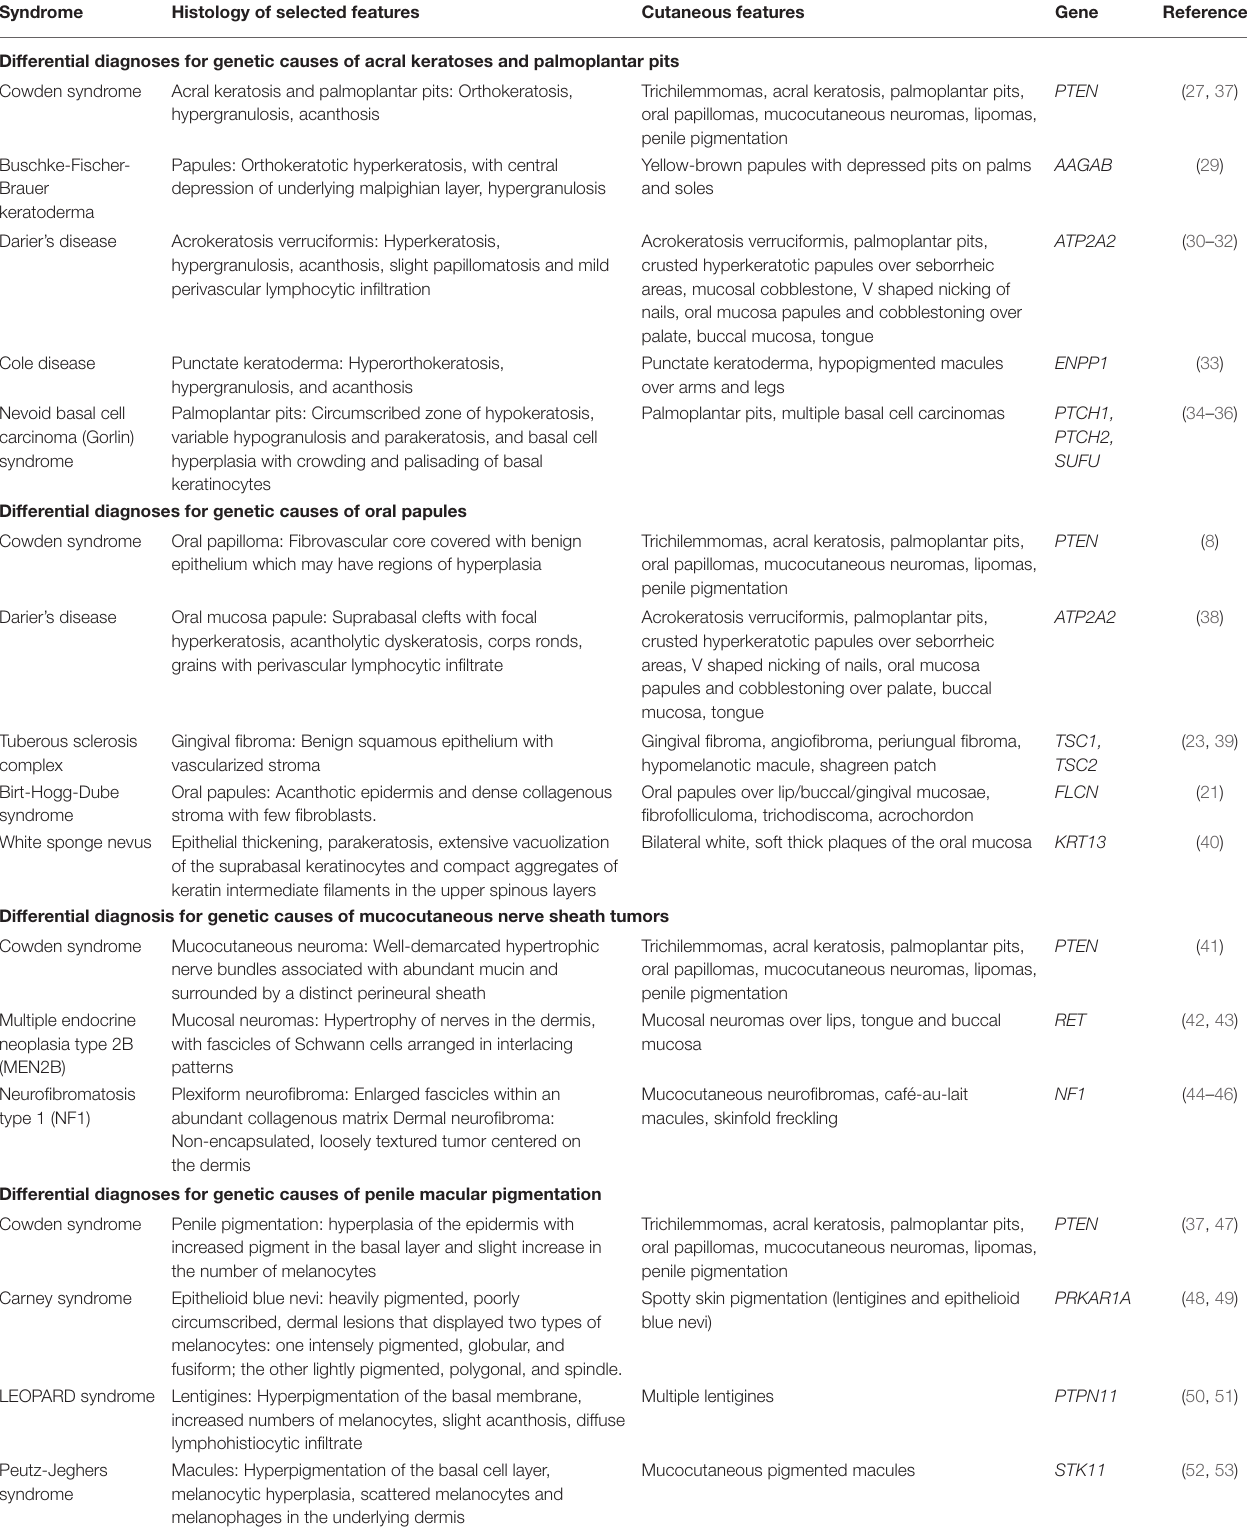
TABLE 2 | Differential diagnoses for genetic causes of acral keratosis, palmoplantar pits, oral papules, mucocutaneous nerve sheath tumors, and penile macular